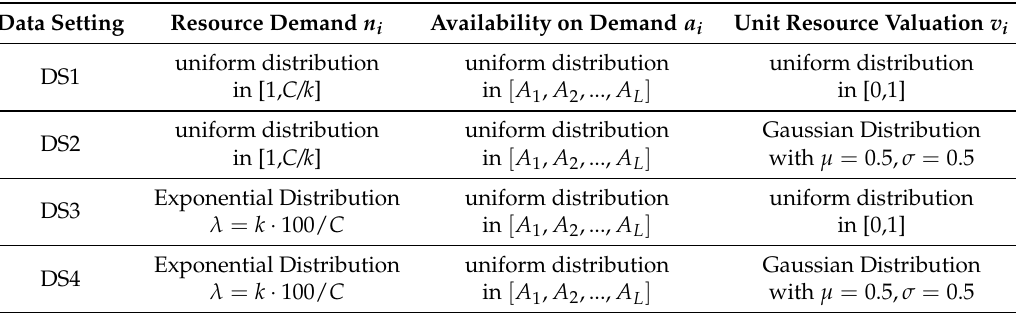
Table 1. Parameter distribution in data